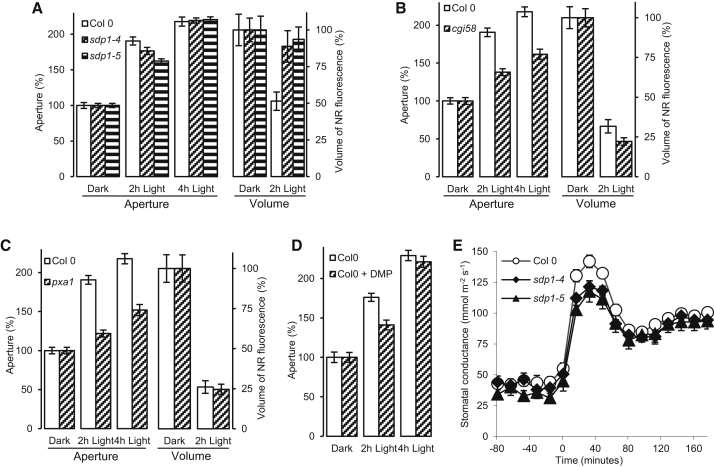
Mutants Carrying Lesions in TAG Catabolism Display Slower Light-Induced Stomatal Opening than Wild-Type(A) sdp1-4 and 1-5 have delayed stomatal opening (p < 0.05 at 2 hr; p > 0.05 at 4 hr; n = 90), and LD breakdown is greatly reduced (p < 0.01; n = 54–62).(B and C) Light-induced stomatal opening is disrupted in cgi58 (B; p < 0.001 at both time points; n = 90) and pxa1 (C; p < 0.001 at both time points; n = 90). LD breakdown is slightly increased in cgi58 (p < 0.05; n = 57–85), but not in pxa1 (p > 0.05; n = 70–97).(D) DMP delays light-induced stomatal opening (p < 0.001 at 2 hr; p > 0.05 at 4 hr; n = 90).(E) sdp1-4 and 1-5 have lower stomatal conductance immediately after a dark to light transition (p < 0.05; n = 8).Error bars represent ±SE. See also Figures S2 and S4.